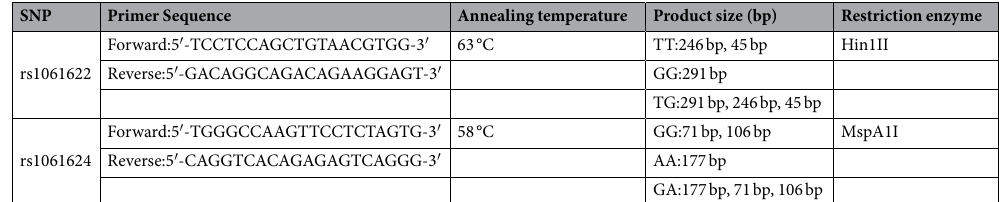
Table 4. Primer Sequence and the Reaction Condition for Genotyping TNFR2 Polymorphisms.